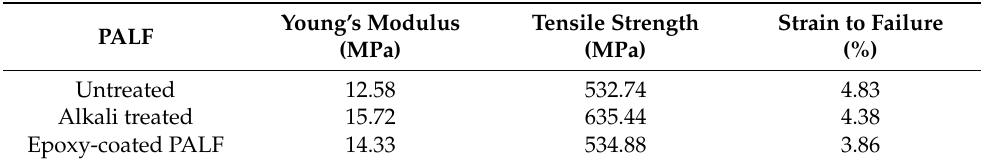
Table 4. Tensile strength of untreated, alkali (NaOH)-treated, and single pineapple leaf fibres (PALF) epoxy composite [99].